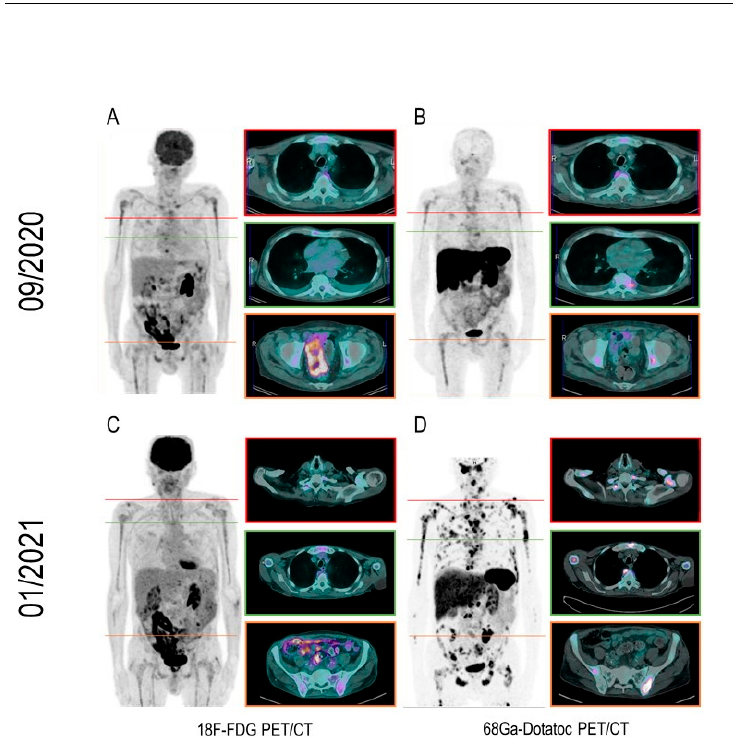
Figure 1. A 69-year-old man was referred to our Institute in June 2012 to diagnose metastatic prostate cancer with a Gleason score of 9 (4 + 5) and lymph nodal and bone involvement since